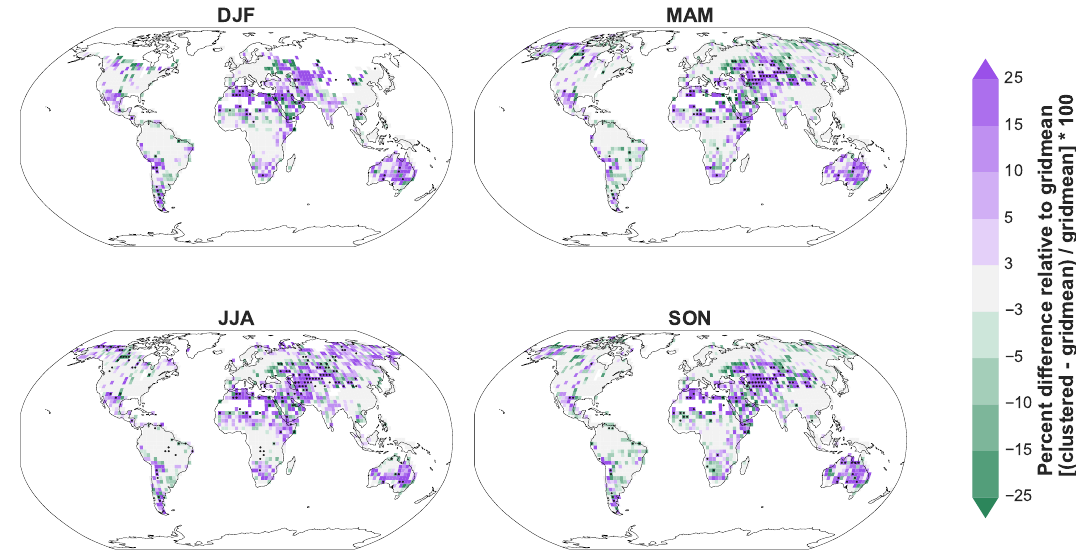
Figure A8. Percent difference in transpiration between the Cluster and Gridmean simulations by season (mean of 1995–2015) following Fig. A7.